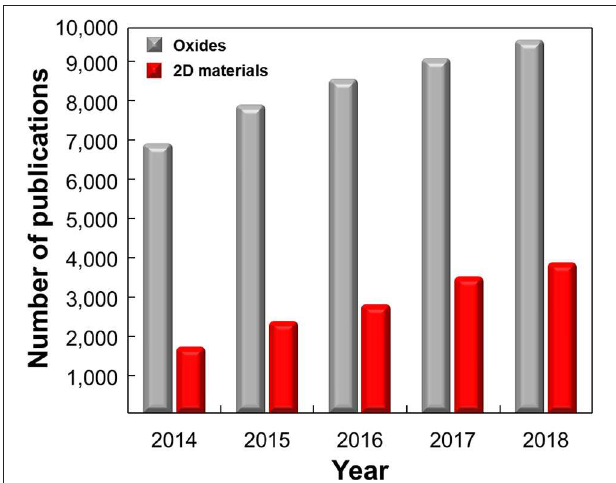
FIGURE 12 | Number of publications on ion/molecule sensors based on 2D materials and metal oxides by years. The data were collected using the Web of Science [v. 5. 32]–Web of Science Core Collection Search: keywords of ((“hydrogen ion” OR glucose OR Pd 2 + OR Sr 2 + OR Cu 2 + OR Cd 2 + OR Hg 2 + OR Pb 2 + OR Cr 4 + OR Ni 2 + OR Co 2 + OR Mn 2 + OR uric OR ascorbic OR dopamine OR DNA OR amino OR protein sens*) AND (graphene OR MoS 2 OR molybdenum disulfide OR black phosphorous OR MoSe 2 OR molybdenum selenide OR WS 2 OR tungsten disulfide OR WSe 2 OR tungsten diselenide)) and ((“hydrogen ion” OR glucose OR Pd 2 + OR Sr 2 + OR Cu 2 + OR Cd 2 + OR Hg 2 + OR Pb 2 + OR Cr 4 + OR Ni 2 + OR Co 2 + OR Mn 2 + OR uric OR ascorbic OR dopamine OR DNA OR amino OR protein sens*) AND (oxide)) were